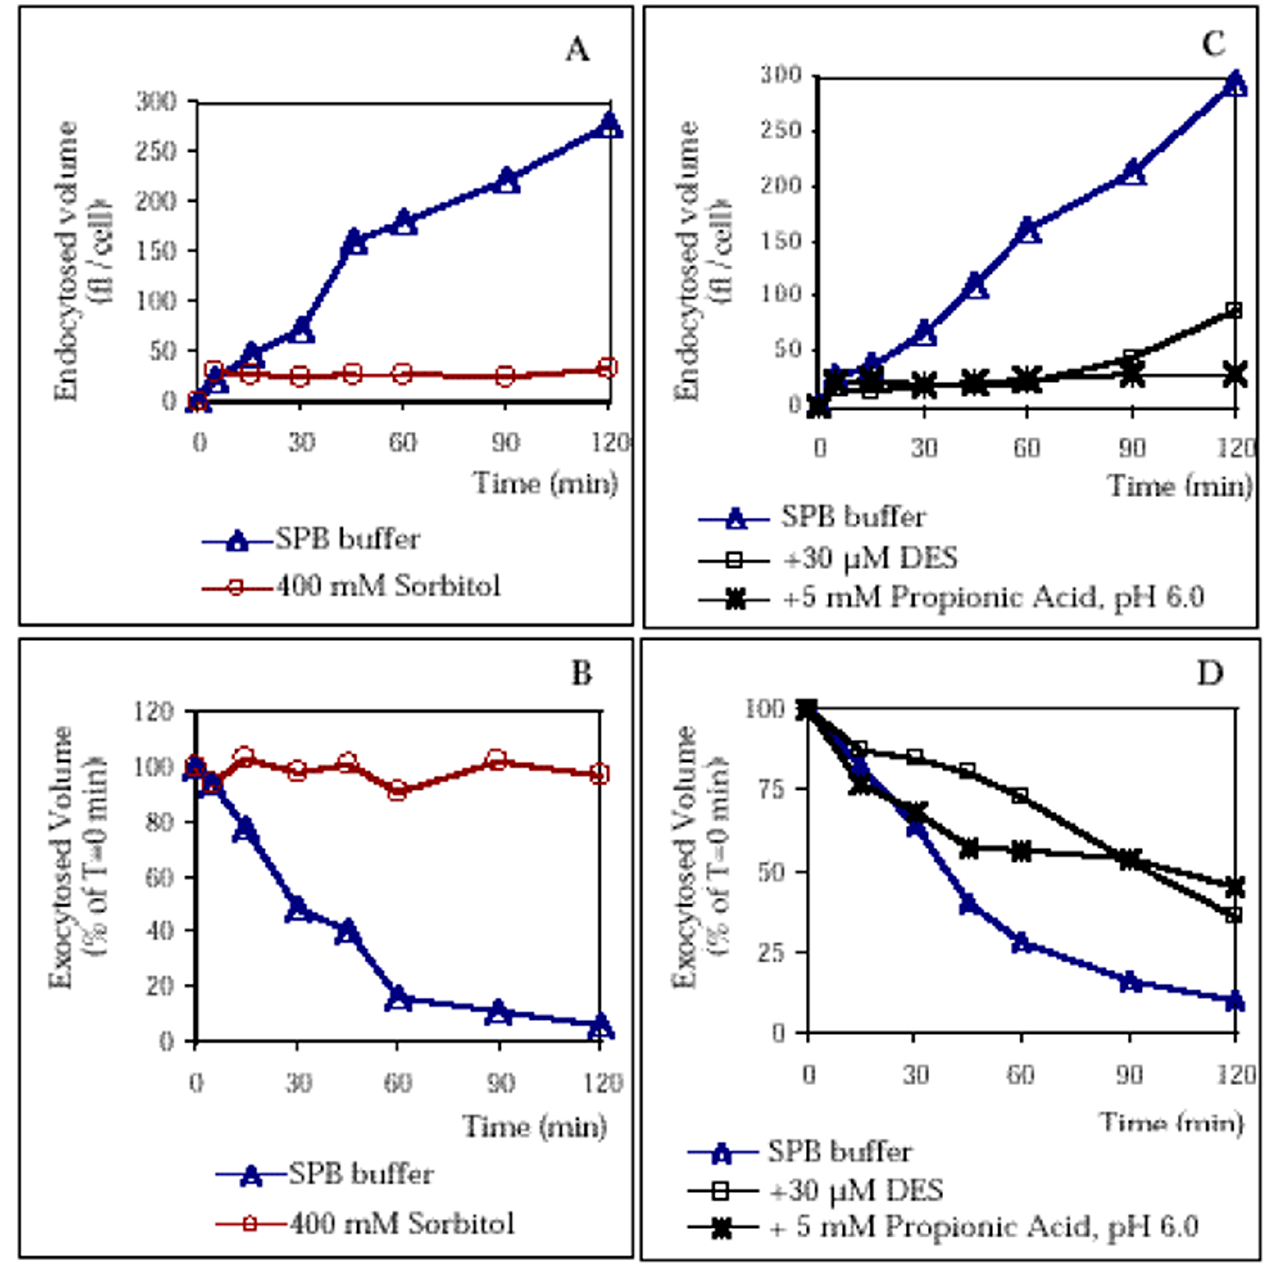
Figure 4 Hyperosmotic stress results in the abolishment of endo- and exocytosis partially due to cytosolic acidification (A) Cells which were resuspended in SPB buffer avidly endocytose the fluorescent fluid-phase marker FITC-Dextran, whereas no fluid uptake was observed with cells exposed to 400 mM sorbitol in SPB buffer. (B) Correspondingly, cells in SPB buffer rap- idly exocytosed ingested FITC-Dextran, whereas no loss of fluorescence was measured with cell suspended in 400 mM sorbi- tol, indicating that exocytosis is blocked. (C) Cells, which were artificially acidified by suspending the cells in SPB buffer/5 mM propionic acid (pH 6.0)/FITC-Dextran did not accumulate any FITC-Dextran, indicating that endocytosis was blocked. Also suspending the cells in SPB buffer/30 µ M DES/FITC-Dextran resulted in the inhibition of endocytosis. However, a resumption of endocytic activity was observed after 1 h of hyperosmotic shock, presumably due to adaptation. As control, cells were sus- pended in SPB buffer/FITC-Dextran. (D) Artificial acidification of cells partially inhibits exocytosis. Control cells labeled with FITC-Dextran exocytosed about 90% of the dye within 2 h, whereas a loss of 55%-60% of cell-associated fluorescence was measured with cells exposed to 5 mM propionic acid or 30 µ M